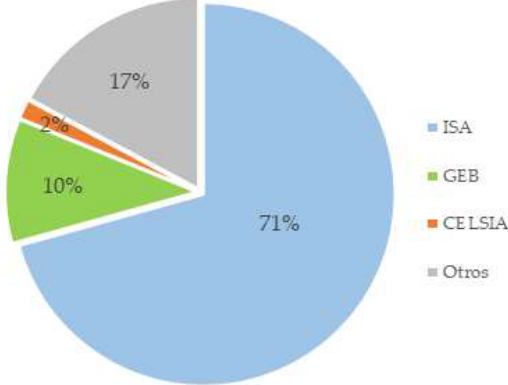
Figure 1. Percentage of ownership of transmission assets by firm. Percentages were calculated based on data from the PARATEC system of XM Compañia Expertos en Mercados [42].